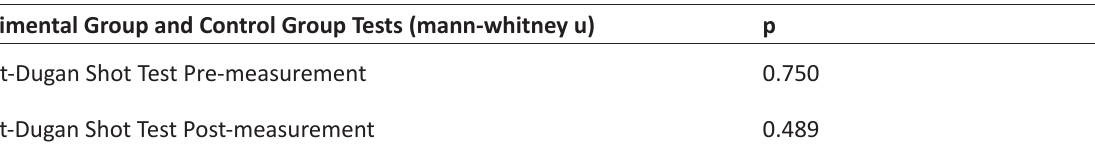
Table 4. Comparison of the test values of Experimental and Control group athletes via Mann Whitney U Test Experimental Group and Control Group Tests (mann-whitney